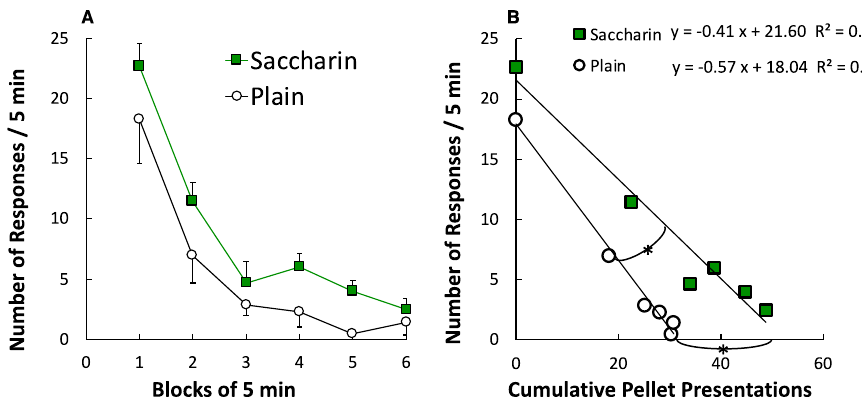
Figure 5. Time courses of lever-press responses in the consumption test. ( A ) Mean response rates (number of lever-press responses per 5 min) as a function of successive 5-min blocks. Data points indicate means ± SEMs ( n = 6 for SAC group and n = 7 for PLA group). ( B ) Mean response rates as functions of cumulative number of sucrose pellet deliveries. Each data point represents the average of the cumulative number of pellet deliveries at the beginning of a 5-min block, and the average of the response rate of that 5-min block. Asterisk indicates a significant difference between the groups in the parameters of Equation (1).